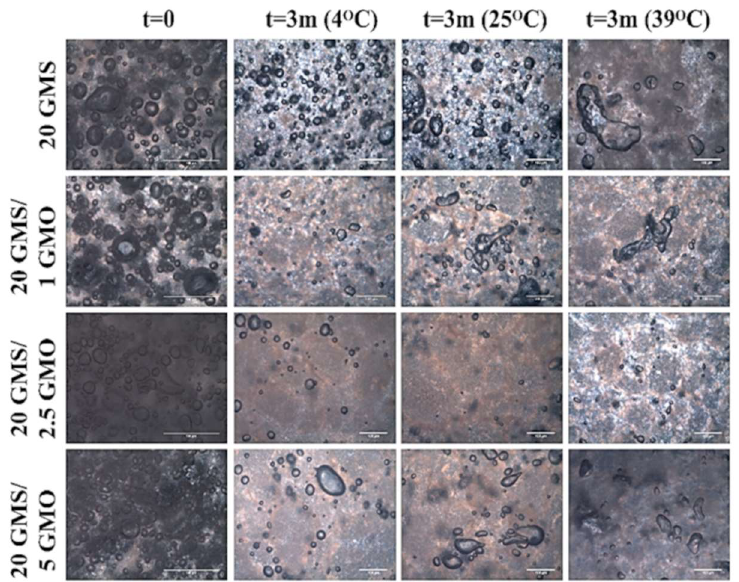
Figure 9. Polarized Light Microscopy micrographs of foams stored for three months under different storage